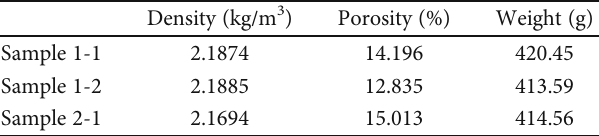
Table 1: Basic physical parameters of sandstone.